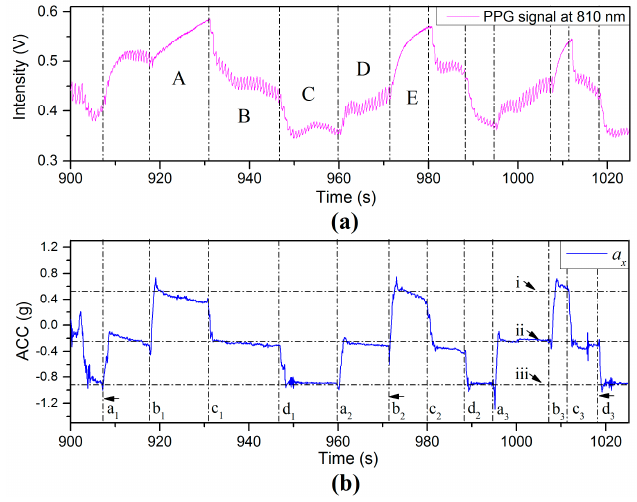
Figure 17. ( a ) PPG and ( b ) X -axis ACC signals captured in the process of swinging the arm up and down with long resting time intervals.